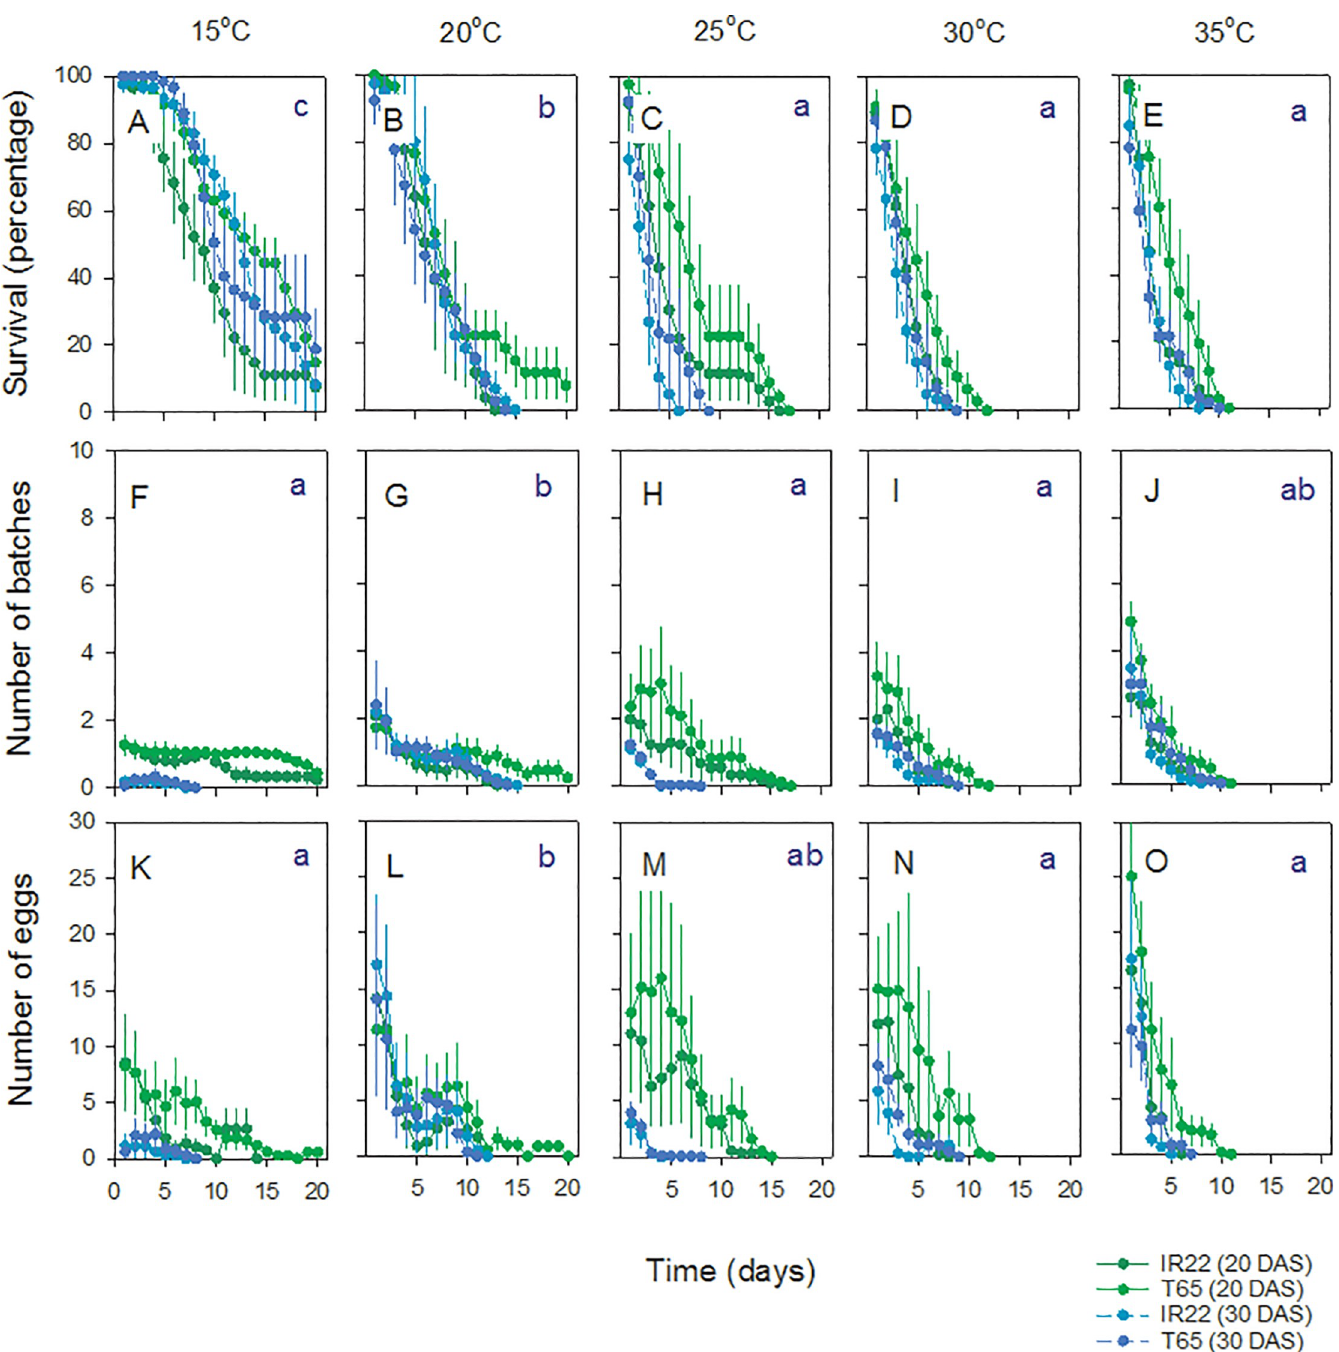
Fig 4. Adult WBPH female survival and egg-laying on indica (IR22) and japonica (T65) rice varieties. Infestations were initiated at 20 and 30 DAS; younger plants are indicated by green symbols and lines. Bioassays were conducted at 15˚C (A,F,K), 20˚C (B,G,L), 25˚C (C,H,M), 30˚C (D,I,N) and 35˚C (E,J,O). Bioassays conducted at 40˚C are not shown (see text). Results for adult survival during the experiment (A-E), the total numbers of batches produced (F-J), and the total number of eggs deposited (K-O) are presented. Standard errors are indicated (N = 4). Lowercase letters indicate homogenous temperature groups for each parameter (Tukey: P > 0.05) based on repeated measures GLMs. See also Table